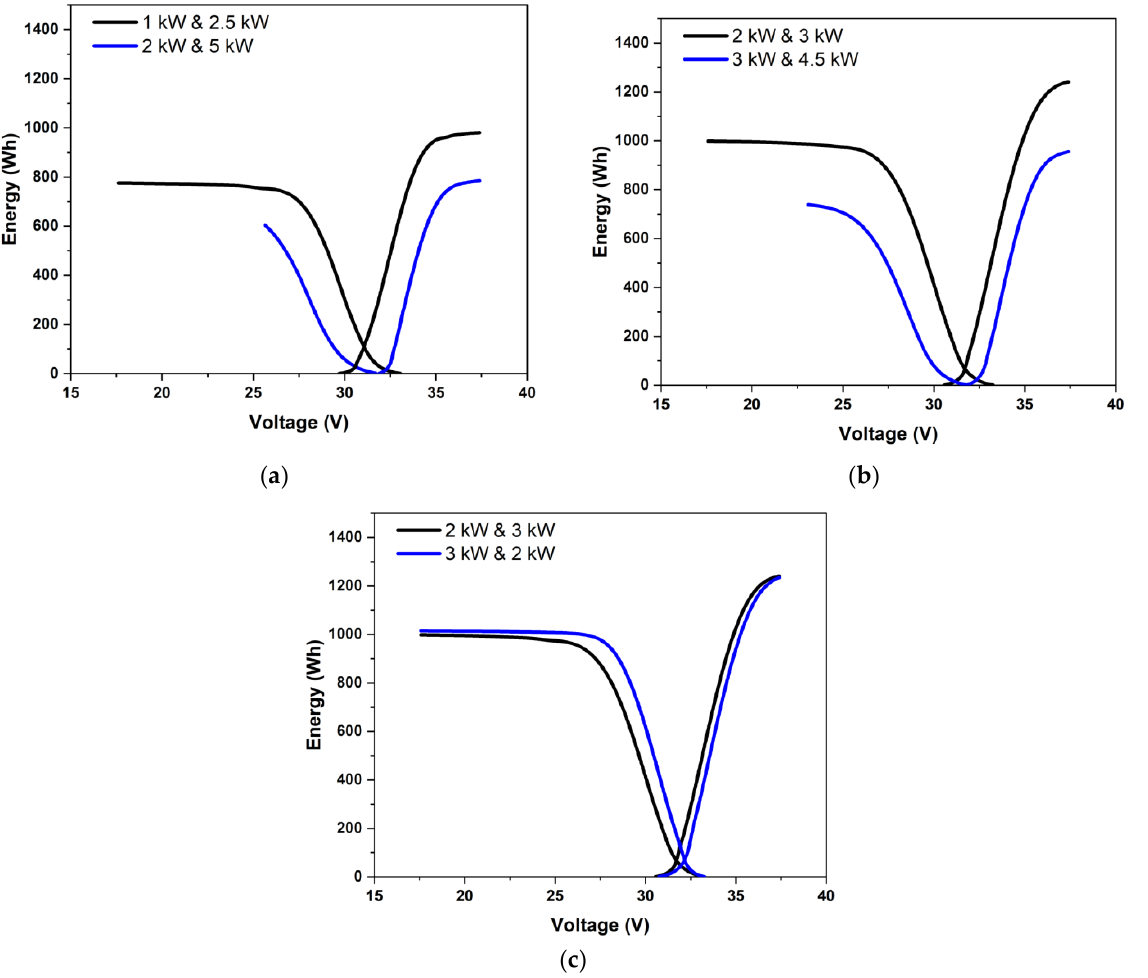
Figure 5. Variation of energy stored and stack voltage during constant power discharging for charging-to-discharging power ratios of ( a ) 0.4, ( b ) 1.5, and ( c ) 0.666 and 1.5. Data at different power levels are shown for ( a , b ).